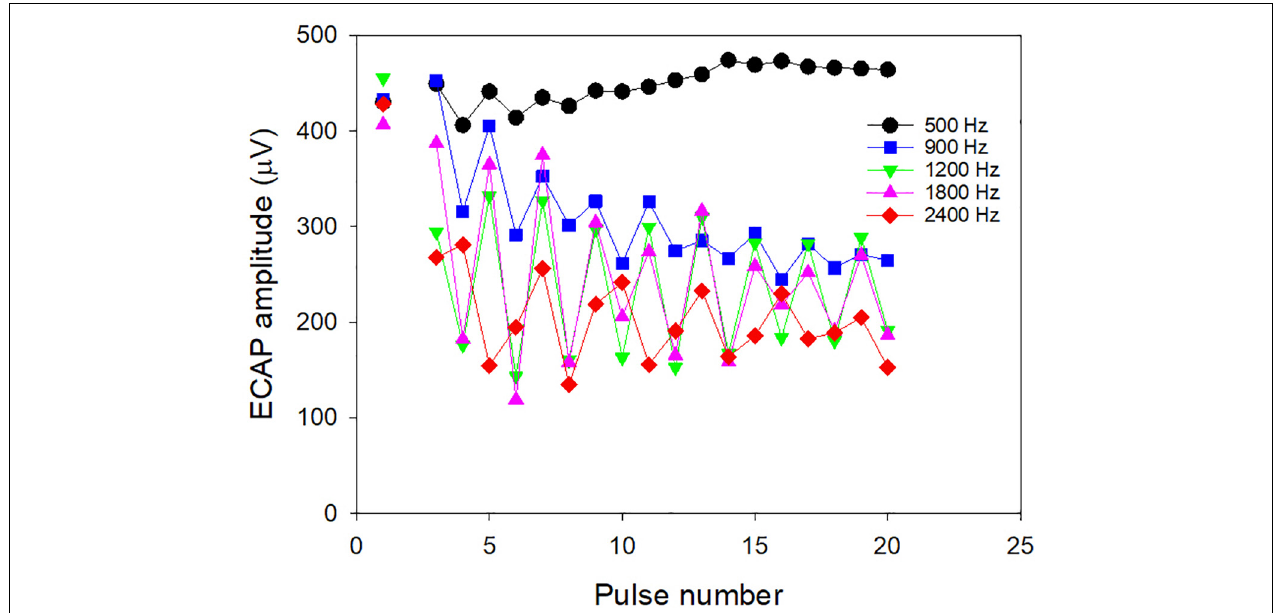
FIGURE 4 | ECAP amplitudes to individual pulses in continuous pulse trains with different rates of stimulation. The unconnected symbols on the left are amplitudes to individual pulses as per the usual clinical measurements of ECAPs. The data was collected by McKay et al.